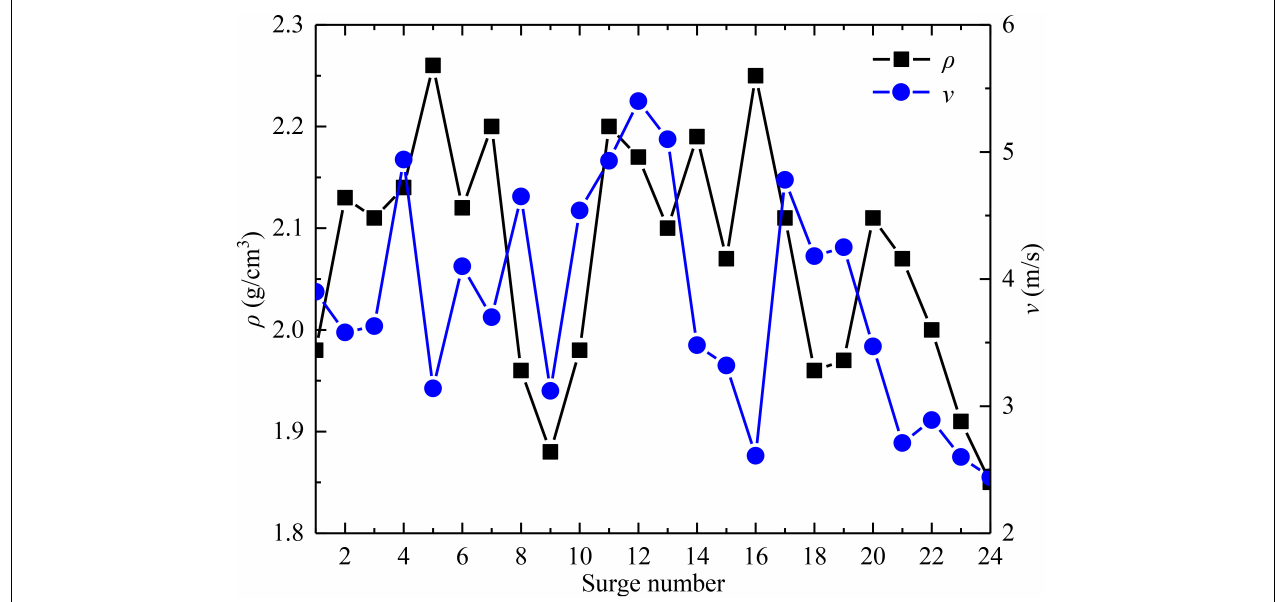
FIGURE 1 | Fluctuation of flow density and velocity of